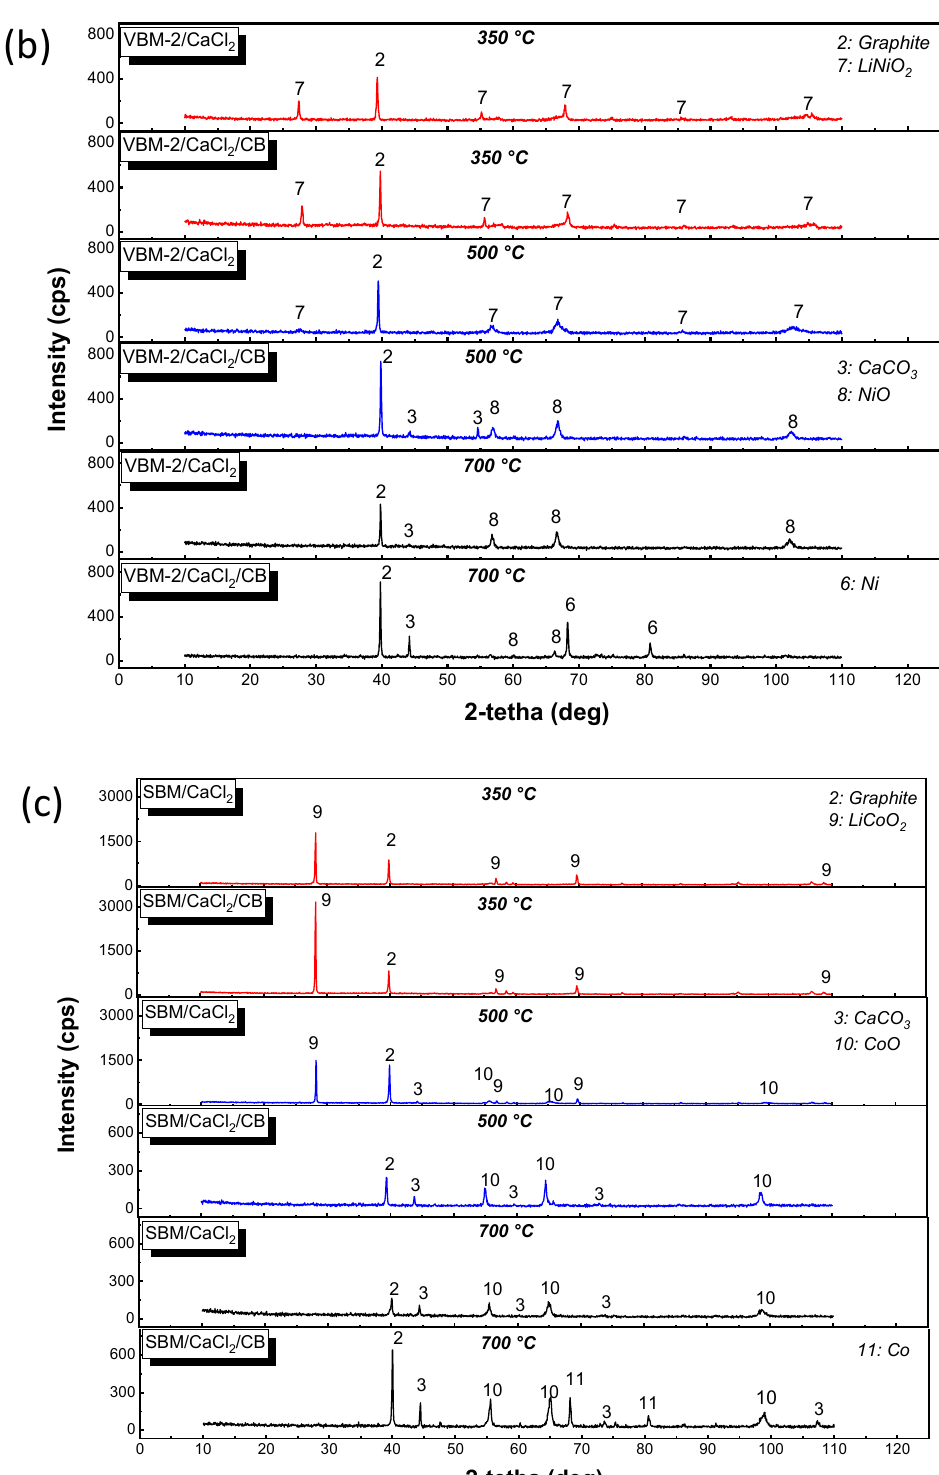
Figure 4. XRD patterns of the NSP samples obtained after the isothermal calcination of both mixtures BM/CaCl 2 and BM/CaCl 2 /CB: ( a ) VBM-1, ( b ) VBM-2, and ( c ) SBM. With respect to VBM-2, at 350 °C, the peaks of the LiNiO 2 phase found in the original sample are also identified in the NSP sample for both systems VBM-2/CaCl 2 and VBM- 2/CaCl 2 /CB. At 500 °C, the peak intensities of the LiNiO 2 phase decrease drastically for the VBM-2/CaCl 2 . In the case of the VBM-2/CaCl 2 /CB system, the phase LiNiO 2 is no longer detected; instead, NiO and CaCO 3 are detected as reaction products. Therefore, we can infer that at 500 °C, LiNiO 2 starts to react with CaCl 2 . When the temperature is increased to 700 °C, NiO and CaCO 3 are the reaction products for the VBM-2/CaCl 2 system. Whereas metallic Ni, CaCO 3 , and NiO are identified as reaction products for the VBM-2/CaCl 2 /CB system. The peaks of the NiO phase are largely reduced in intensity.